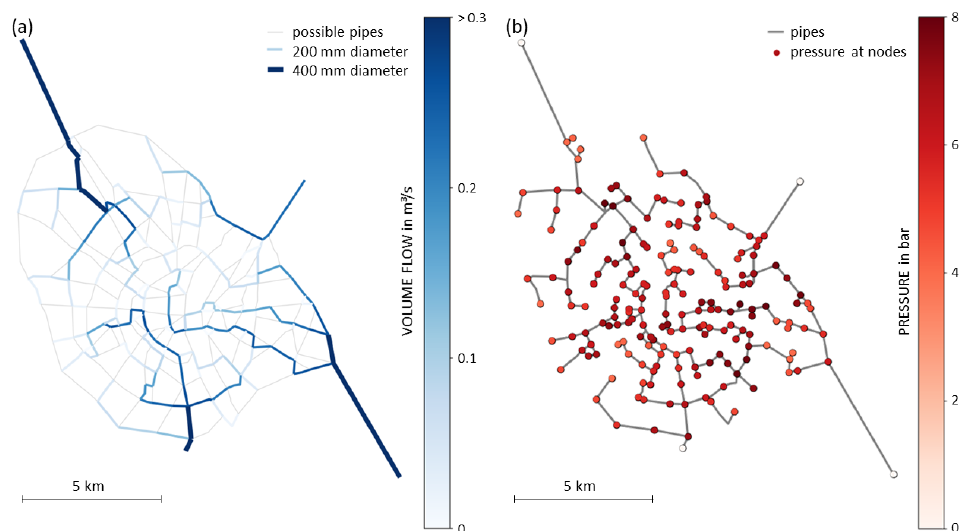
Figure 5. Quasi-stationary behavior of the generated WDS. ( a ) Volume flow in the pipes, ( b ) pressure at demand